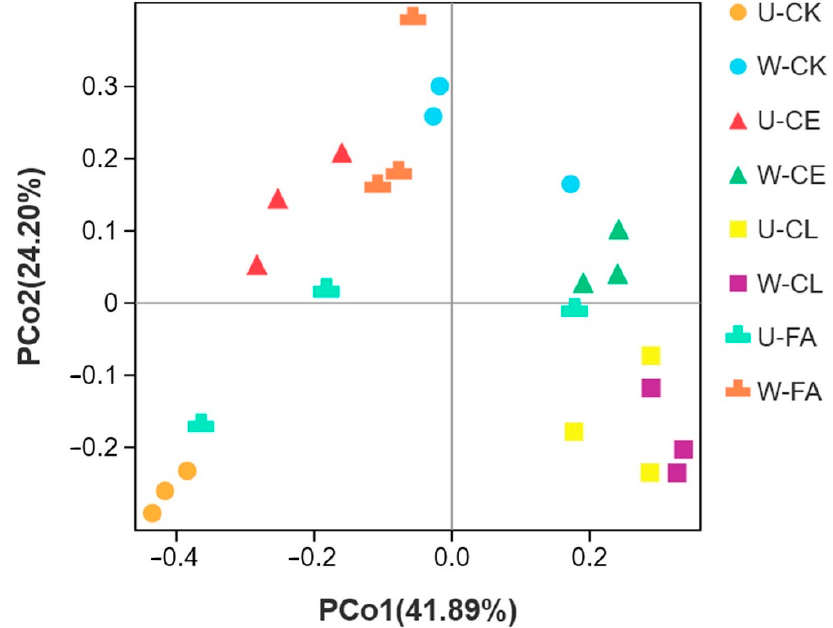
Figure 5. Principal co-ordinates analysis (PCoA) and ANOSIM analysis of B. papyrifera silages . U, wilt 0 h; W, wilt 3.5 h; CK, control (no additives); CL, Enterococcus durans ; CE, cellulase; and FA, formic acid. The distance between treatments represents the degree of bacterial community difference, and the closer the distance, the more similar the difference.